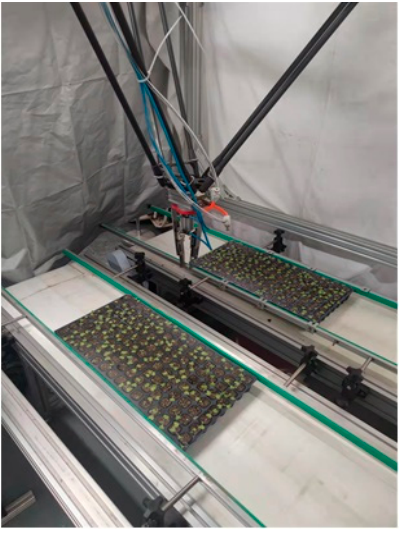
Figure 16. Transplanting process of the whole machine.